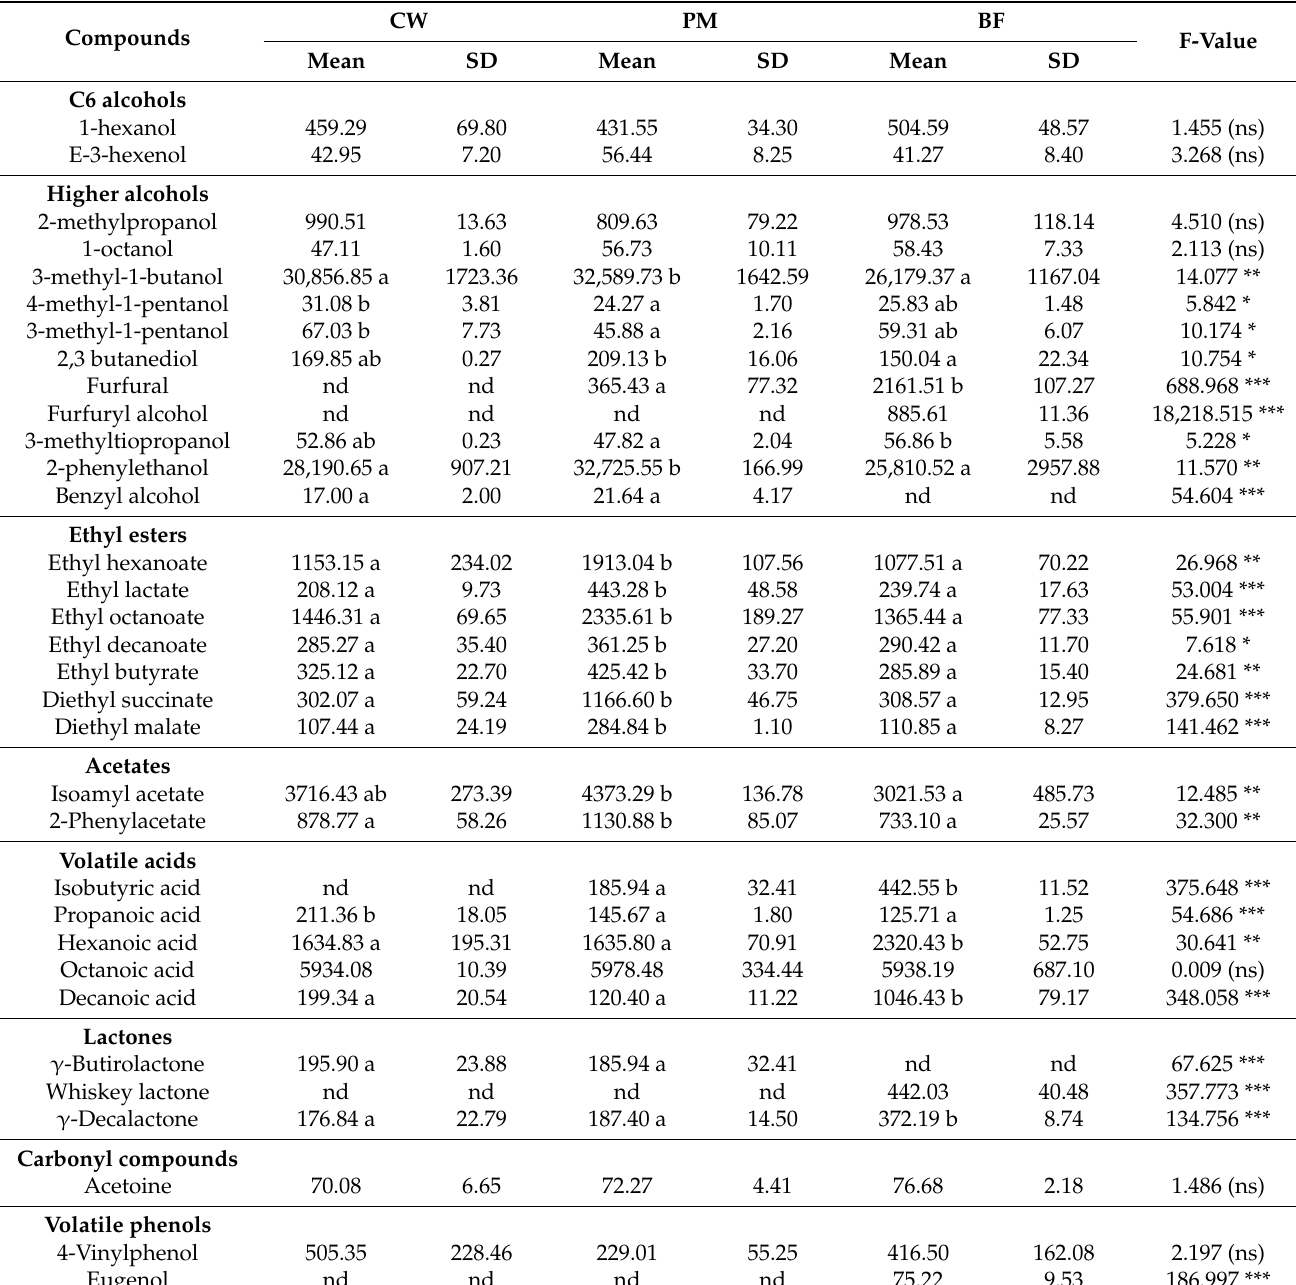
Table 2. Concentration ( µ g/L) of volatile compounds of Maturana Blanca wines produced by conventional winemaking (CW), conventional winemaking with pre-fermentative maceration (PM), and barrel fermentation (BF).